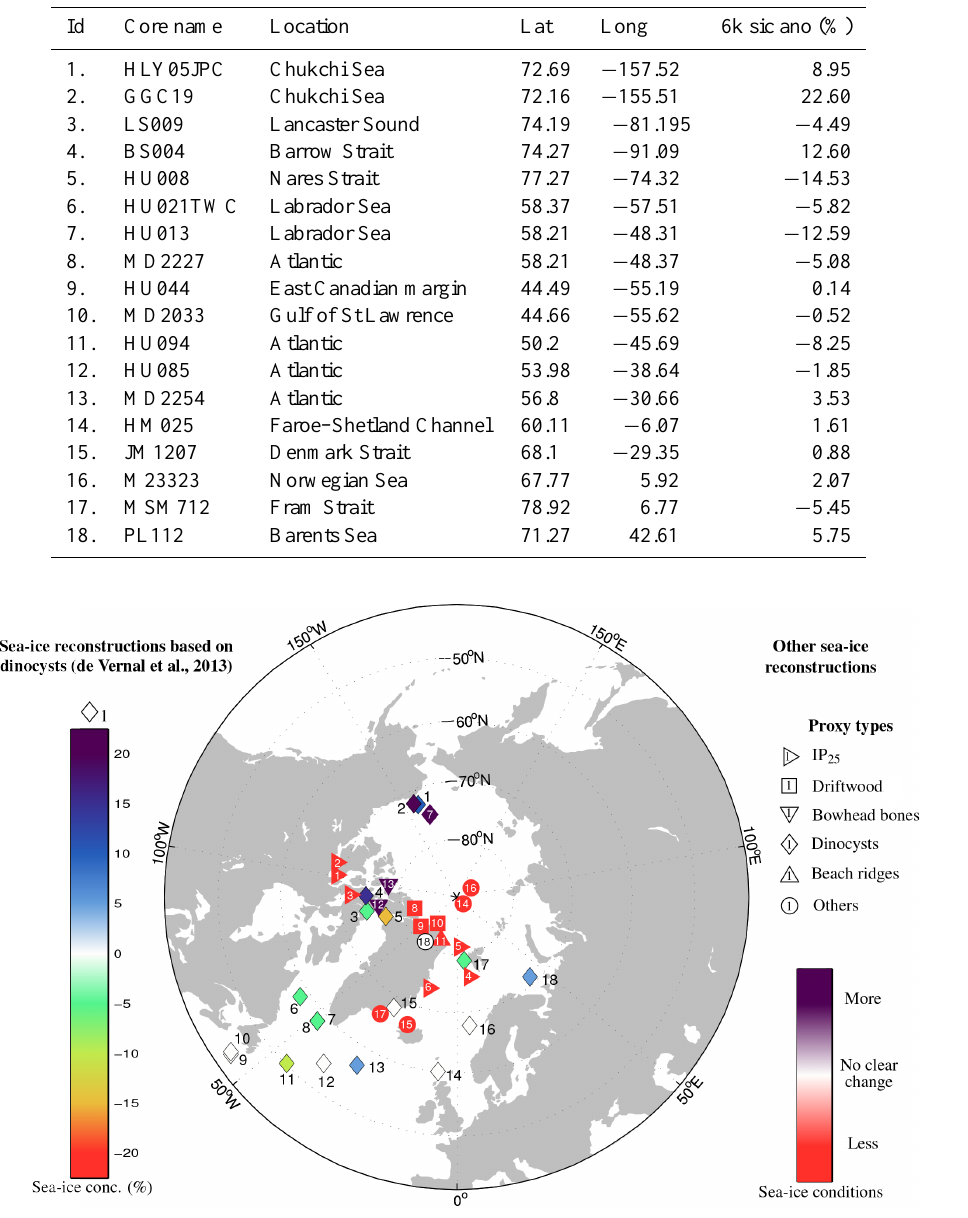
Table 2. Description of all the cores available at 6 ± 0 . 5ka (AD − 4050 ± 0 . 5kyr) used to reconstruct sea ice cover (de Vernal et al., 2013a). The table shows the core ids used in this study, their name, location, latitude, longitude and the reconstructed sea ice concentration (sic ano) anomalies (reference period AD1850–1900).